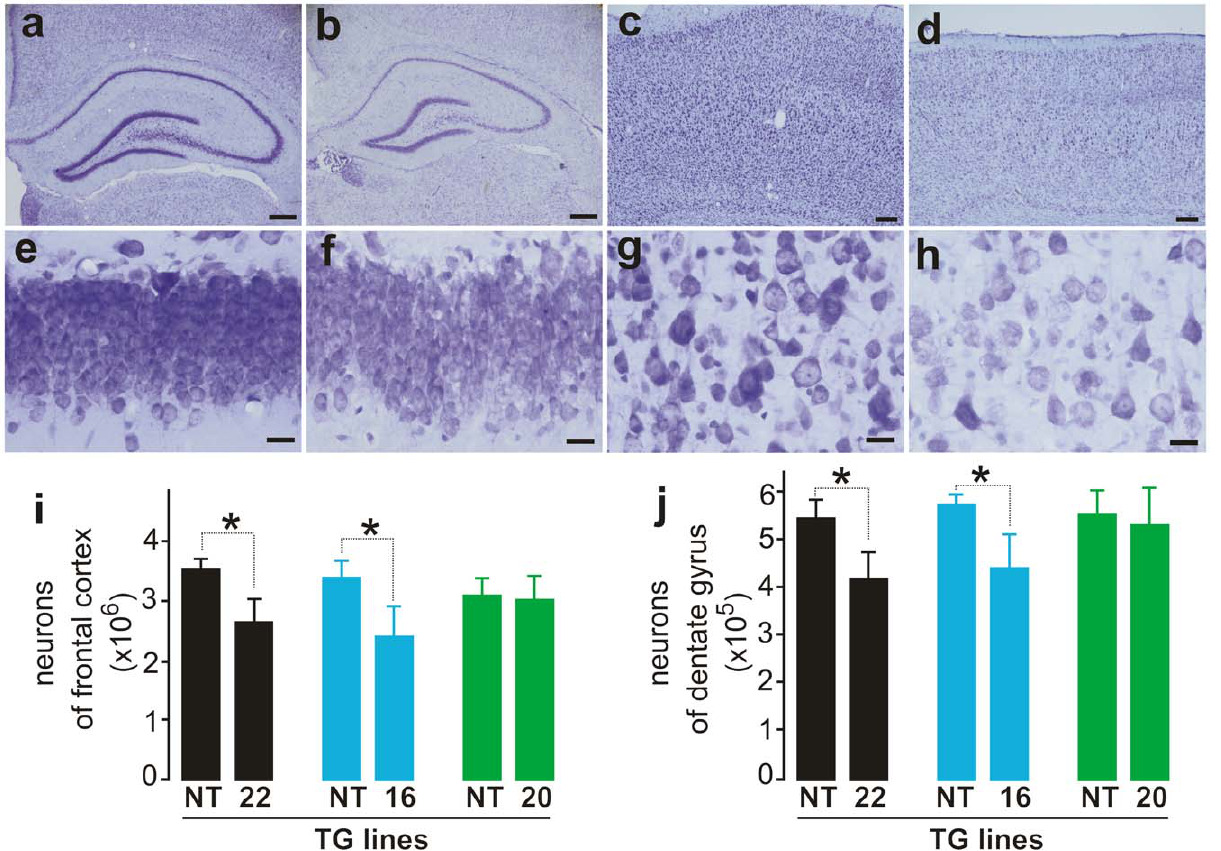
Figure 3. Loss of neurons in the cortex and hippocampus of mutant FUS transgenic rats. (A–C) Cresyl violet staining of hippocampus (A–B and E–F) and cortex (C–D and G–H) showed faint staining in the tissues of mutant FUS transgenic rats at disease end-stages (B, D, F, and H) compared to age-matched nontransgenic rats (A, C, E, and G). Scale bars: A–B, 400 m m; C–D, 50 m m; and E–H, 20 m m. (I, J) Stereological cell counting revealed a loss of neurons in the cortex (I) and dentate gyrus (J) of mutant FUS transgenic rats (lines 16 and 20). The CAG-tTA single transgenic rats and nontransgenic rats were combined as control rats (NT) because no difference was observed between these rats. Mutant FUS transgenic rats were killed at disease end-stages and paired control rats were killed at matched ages. Normal FUS transgenic rats and their paired controls were killed at 70 days of age, by which time mutant FUS transgenic rats had reached disease end-stages. Data are presented as means 6 SD ( n =5–7). * p , 0.05.